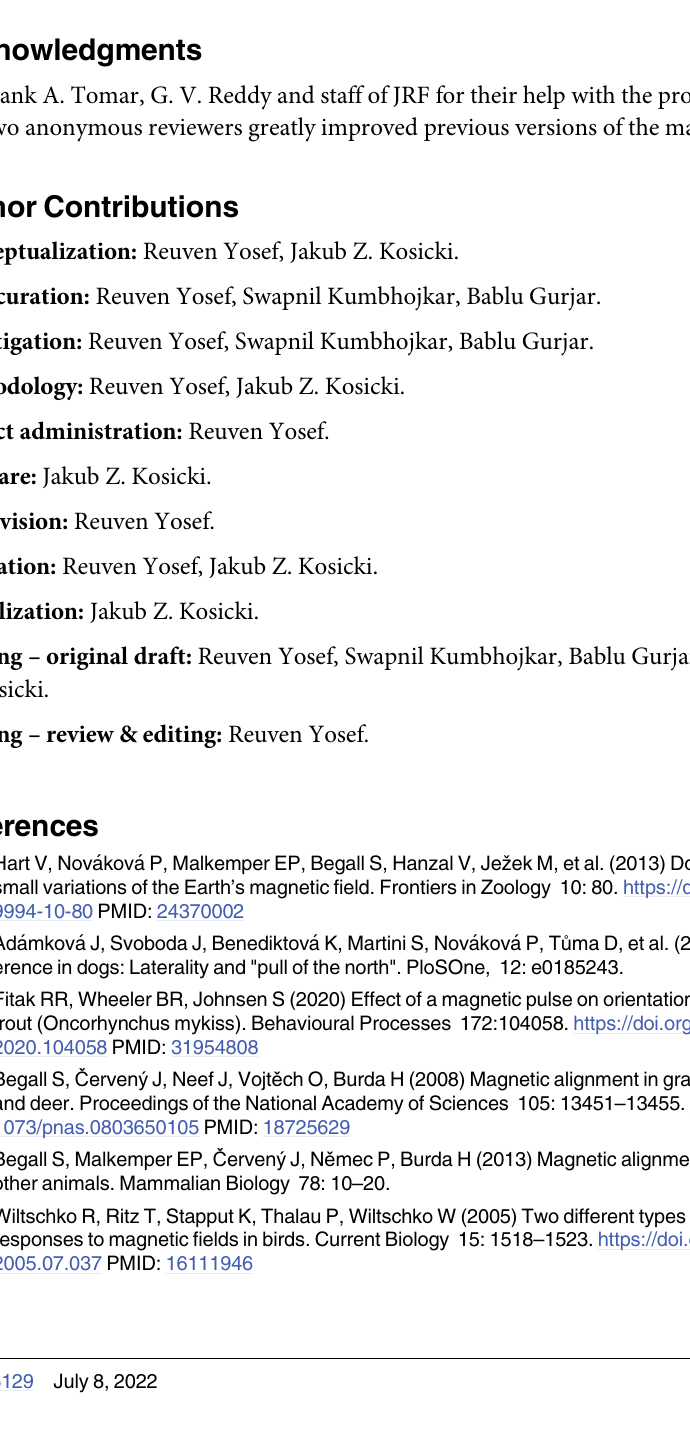
S1 Table. Detailed information about all samples used in the study.